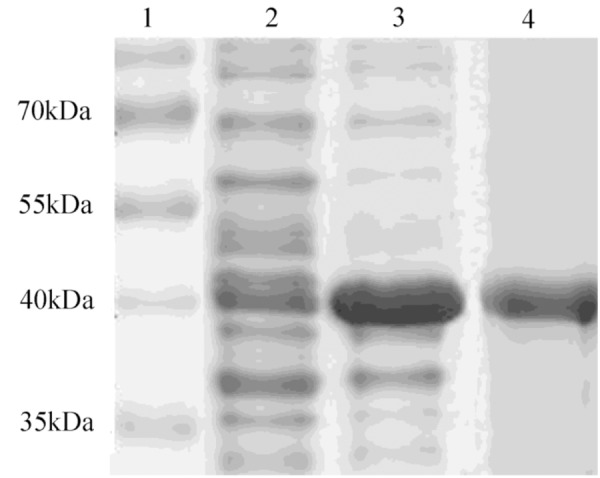
SDS-PAGE analysis of recombinant protein. Lane 1, markers; lane 2, positive transformant Escherichia coli without IPTG induction; lane 3, positive transformant E. coli induced by IPTG; and lane 4, purified protein.